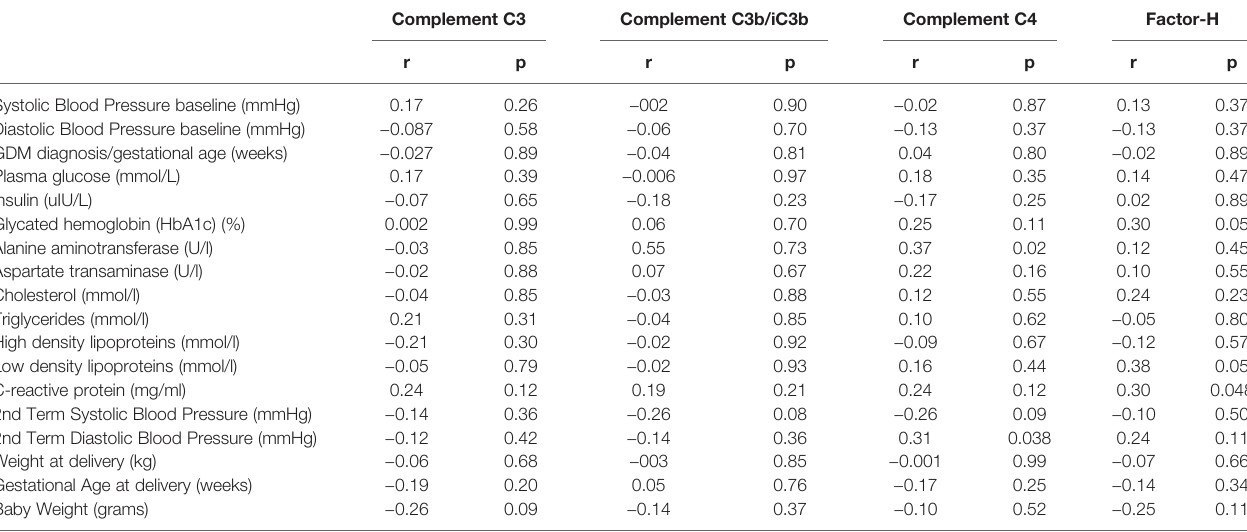
TABLE 3 | Partial correlations of complement C3, complement C3b/iC3b, complement 4, and Factor-H with demographic and biochemical data for the combined cohort (control and GDM).